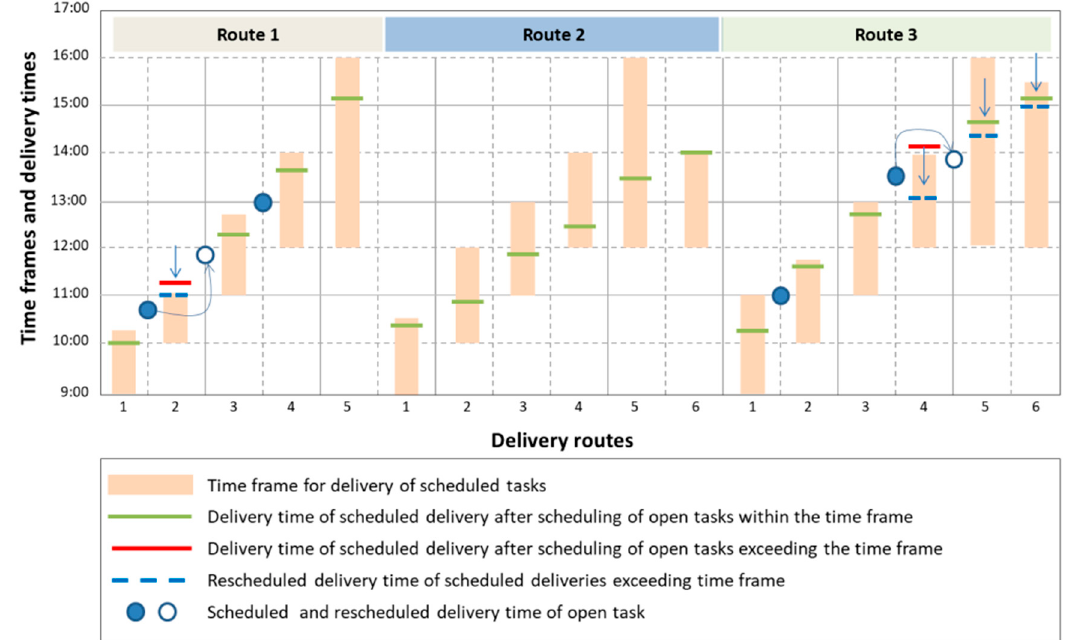
Figure 17. Results of rescheduling of open tasks not to exceed constrained time frames.